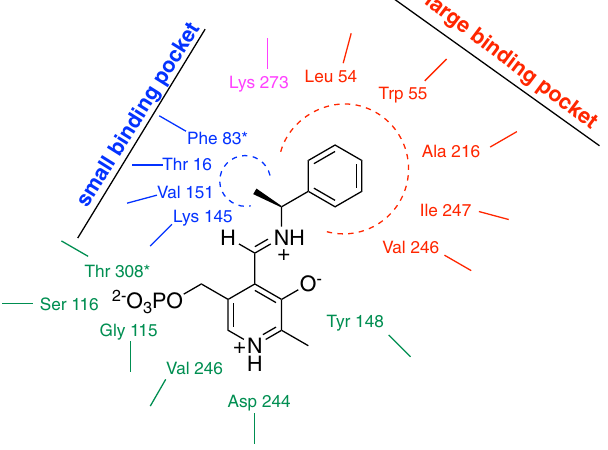
Figure 1. Schematic representation of the small and large binding pockets of VbT A. Phe 83 * and Thr 308 * belongs to the second subunit. Asp 244, Val 246 and Tyr 148 (in green) stabilise PLP aromatic ring; Gly 115, Ser 116, and Thr 308 * coordinate the PLP phosphate group; whereas Lys 273 is the catalytic residue. The model is based on the alignment analysis and the molecular modeling based on the resolved structure of the amino transferase from V. fluvialis (PDB: 4E3Q) 37